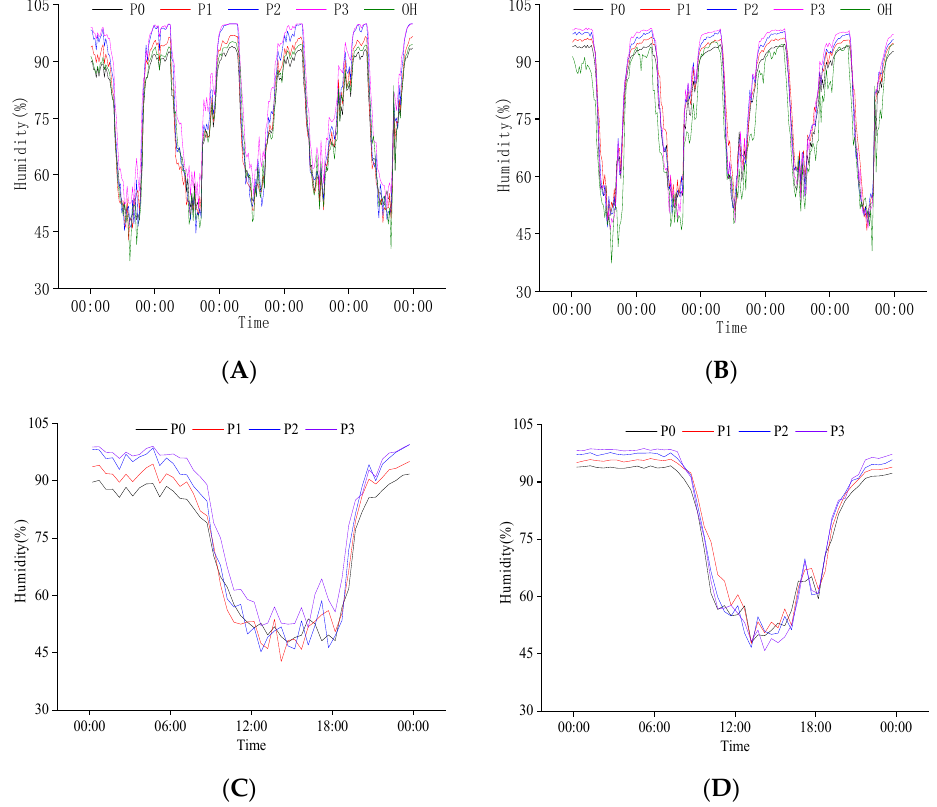
Figure 7. Daily variation in population humidity at the heading stage. ( A ) Canopy humidity of population from 26 July to 30 July; ( B ) Baselayer humidity of population from 26 July to 30 July; ( C ) Canopy humidity of population on 26 July; ( D ) Baselayer humidity of population on 26 July. OH is the change in external humidity, P0, P1, P2, and P3 are the effects of different nitrogen fertilizers on population humidity under N1 conditions.